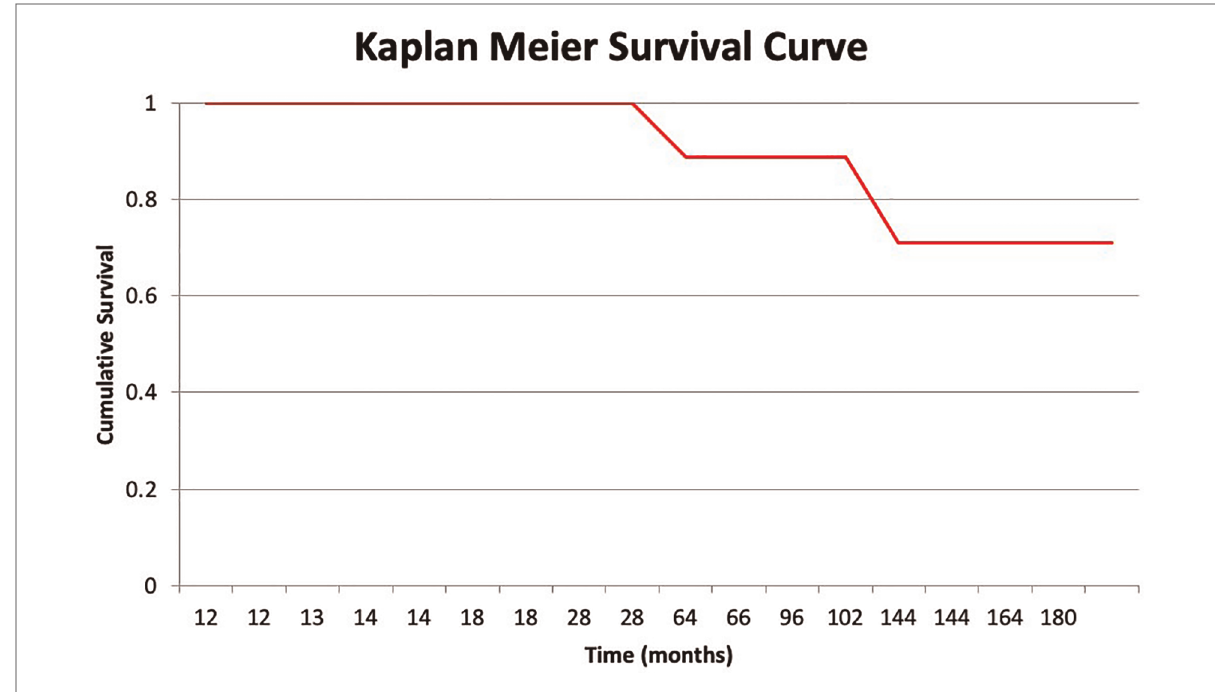
FIGURE 4 Kaplan-Meier survivorship curve of study